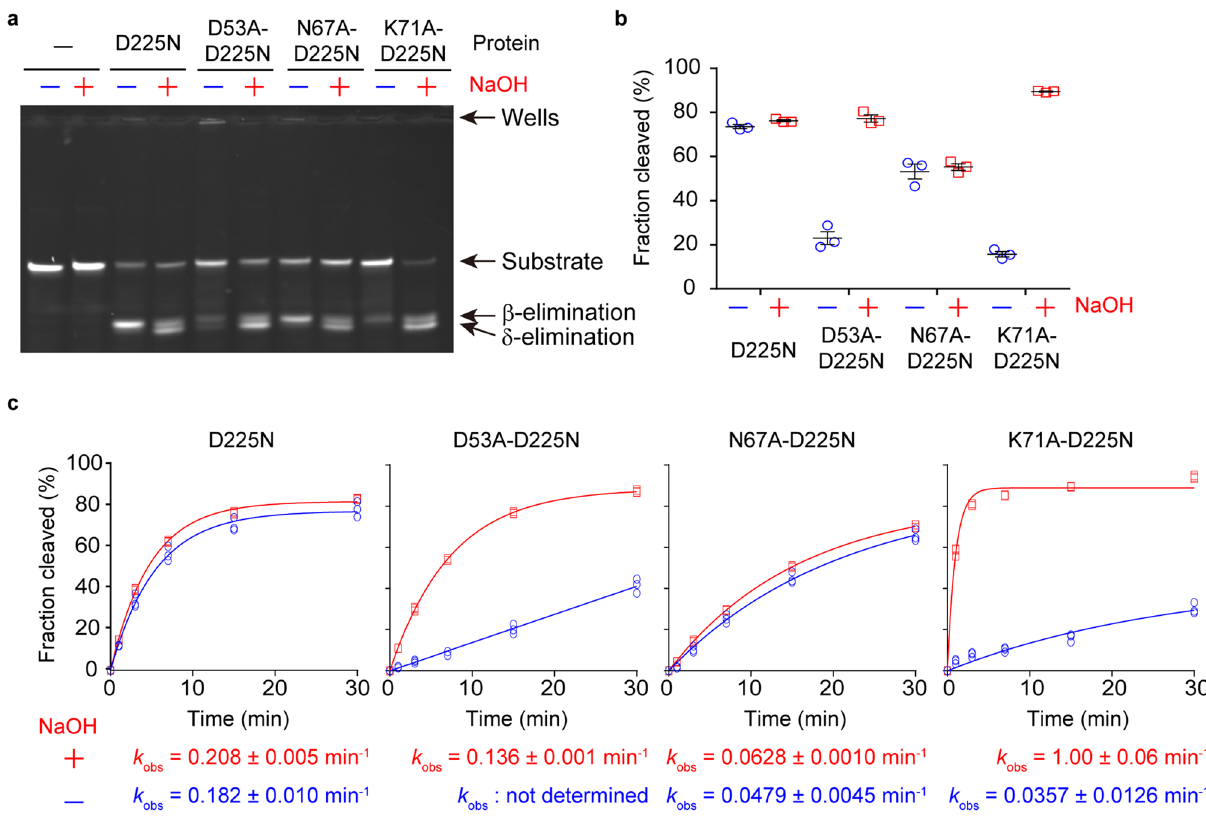
Figure 5. Mutation assay. ( a ) DNA glycosylase activity assay of the R.CcoLI mutants at 37 °C for 15 min. After the reaction, half of the solution was treated with NaOH to generate strand breaks at AP sites (β- and δ-eliminations). Data are representative of three independent experiments. The image is a cropped gel image. The full image is in Supplementary Fig. S7 online. Fraction cleaved = volume of cleaved DNA/(volume of cleaved DNA + volume of uncleaved DNA + volume of DNA stuck in the well) ( b ) Quantification of a . The fractions of products are indicated as blue circles and red squares. Data are the means ± SEM from three independent experiments. ( c ) Kinetics experiments for the DNA glycosylase activities of the R.CcoLI mutants at 37 °C. The enzymatic rate constant and its standard error were obtained from a single-exponential fit to the data from three independent (Fig. 3a,b). Due to the formation of the antiparallel β-sheet structure, the side-chain amine group of Lys71 is located near the N -glycosidic bond of deoxyadenosine (Fig. 4b). Lys71 of R.CcoLI is conserved in R.PabI as Lys73. The superposition of the structures of R.CcoLI and R.PabI shows that the Cα atom of R.CcoLI Lys71 is close to that of R.PabI Lys73 (~ 3 Å). However, the R.CcoLI-specific β-sheet formation causes the inversion of the side chain direction of Lys71 (Fig. 3b). The enzymatic activity assays demonstrated that Lys71 of R.CcoLI is important for AP lyase activity (Fig. 5a–c). These results indicate that the AP lyase activity of R.CcoLI is facilitated by the insertion of the antiparallel β-sheet structure near the active site. The amino acid sequence of the charac- teristic antiparallel β-sheet structure of R.CcoLI is largely conserved in R.HpyAXII (Fig. 1a), which is the R.PabI homolog from mesophiles that also shows significant AP lyase activity 15 . Although the structure of R. HpyAXII has not been determined, this sequence similarity suggests that the corresponding region of R. HpyAXII forms an antiparallel β-sheet structure similar to R.CcoLI. The insertion of the antiparallel β-sheet structure in this region is predicted to be a signature of the HALFPIPE superfamily enzymes with AP lyase activity (bifunctional DNA glycosylase). As mentioned in the results section, the K71A-D225N mutant showed weak DNA cleavage activity. R.CcoLI is also predicted to cleave dsDNA through a Lys71-independent mechanism. However, the Lys71-independent DNA cleavage mechanism of R.CcoLI has not been elucidated to date. In general, the thermostabilities of proteins have been attributed to several factors: increased numbers of ion-pair networks on protein surfaces, loop shortening and decreased numbers of hydrophobic accessible surface areas 29–33 . In the R.PabI structure, loop regions that correspond to the β10–β11 and η1–β14 loops of R.CcoLI are shortened compared to the structure of R.CcoLI (Fig. 3a). These loop shortenings are predicted to be important for the high thermostability of R.PabI. The existence of the additional antiparallel β-sheet structure near the active site is characteristic of R.CcoLI. However, this structure is truncated in R.PabI (Fig. 3a,b). In the R.CcoLI structure, this region shows relatively high temperature factors compared to the protein core region (Fig. 6a,b and Supplementary Fig. S5 online). It is predicted that the truncation of this region is also important for the high thermostability of R.PabI. In the R.CcoLI structure, the hydrophobic residues in the N-terminal region (Phe3, Ile5 and Tyr7) are exposed to the solvent. In contrast, the corresponding region of R.PabI is covered by the additional